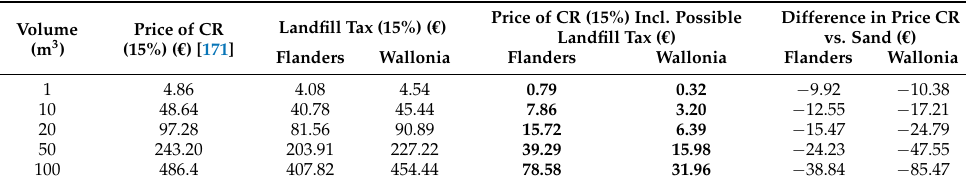
Table 3. Processed CR (15%) price vs. sand (15%) in